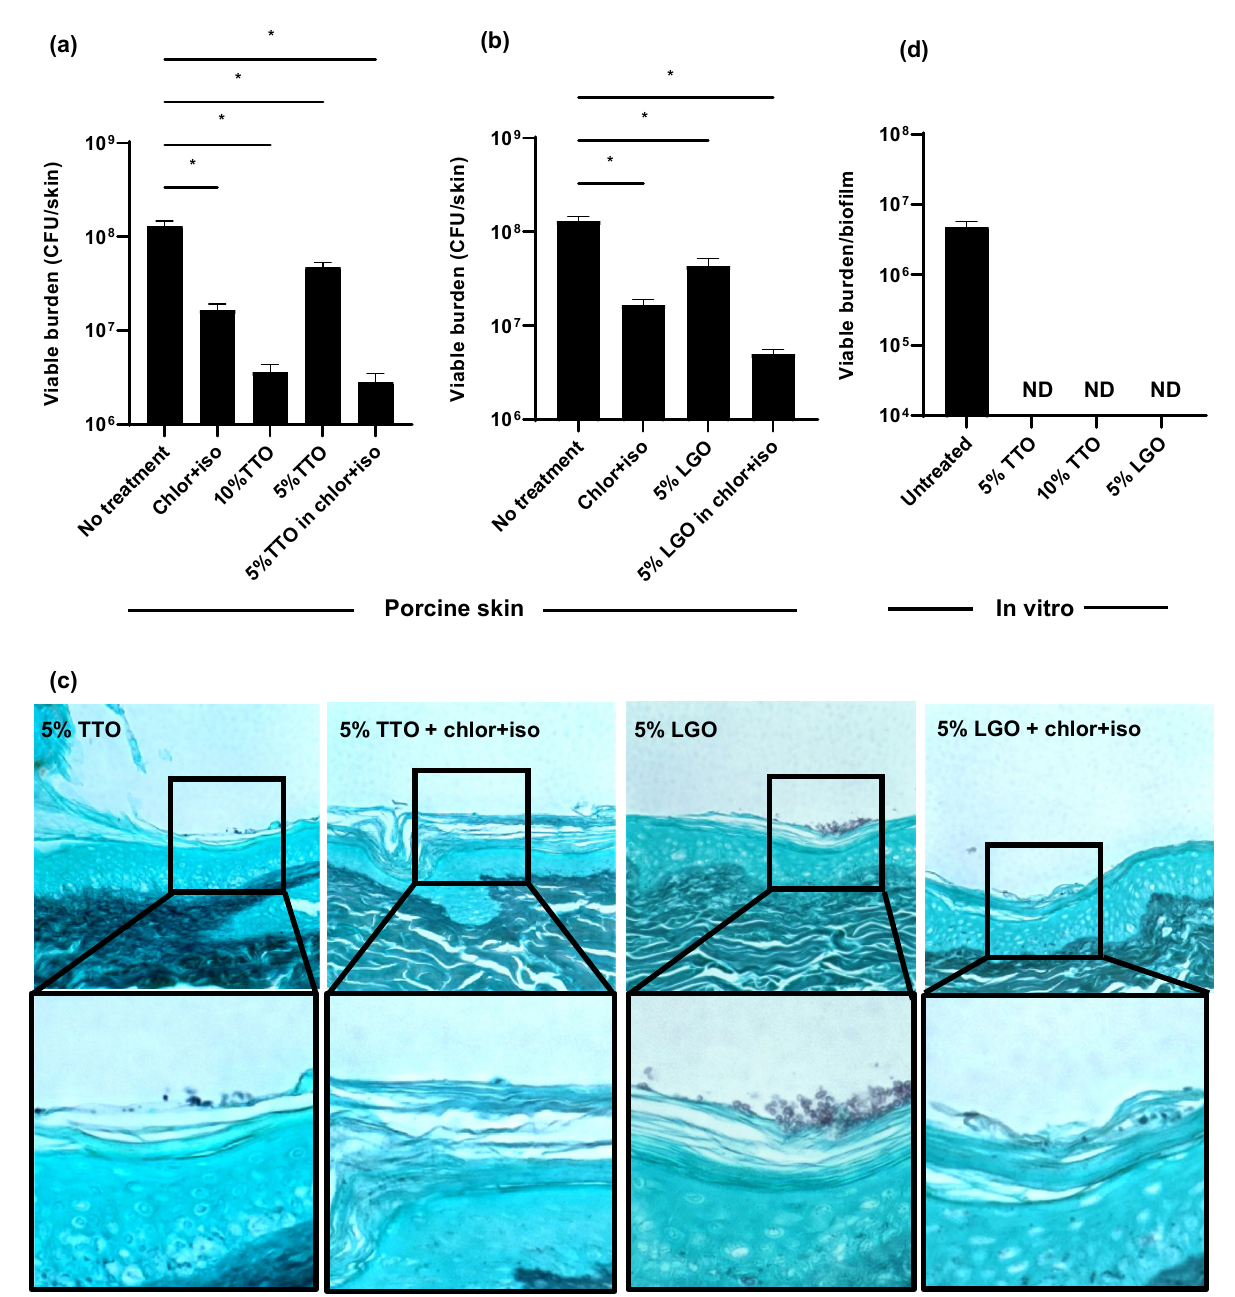
Figure 3. Impact of biocides on C. auris skin colonization and in vitro: ( a – c ) C. auris was applied to the surface of full- thickness porcine skin samples. After 24 h, biocides were applied for 1 h, and samples were incubated for 24 h. The impact on colonization was assessed by viable burden ( a , b ) and histopathology with Grocott’s methenamine silver staining ( c ). ( d ) C. auris biofilms were propagated in synthetic sweat media in 12-well plates for 24 h. Essential oils were applied for 1 h and the remaining viable burden was determined by plating. Data were analyzed by one-way ANOVA with Holm–Sidak multiple comparison on the control, ND = not detectable, * p < 0.05, NS = not significant, standard error of the mean shown, n = 3.